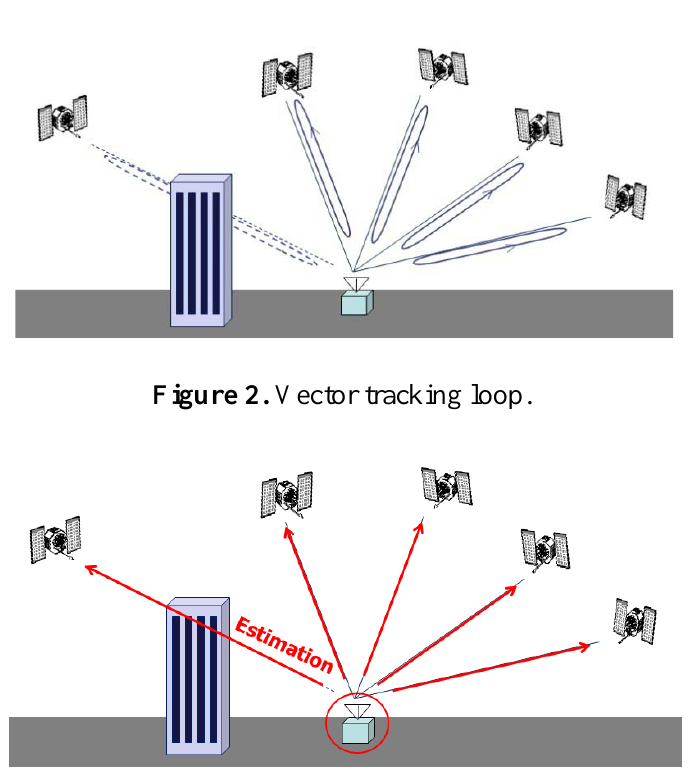
Figure 1. Independent tracking loop.